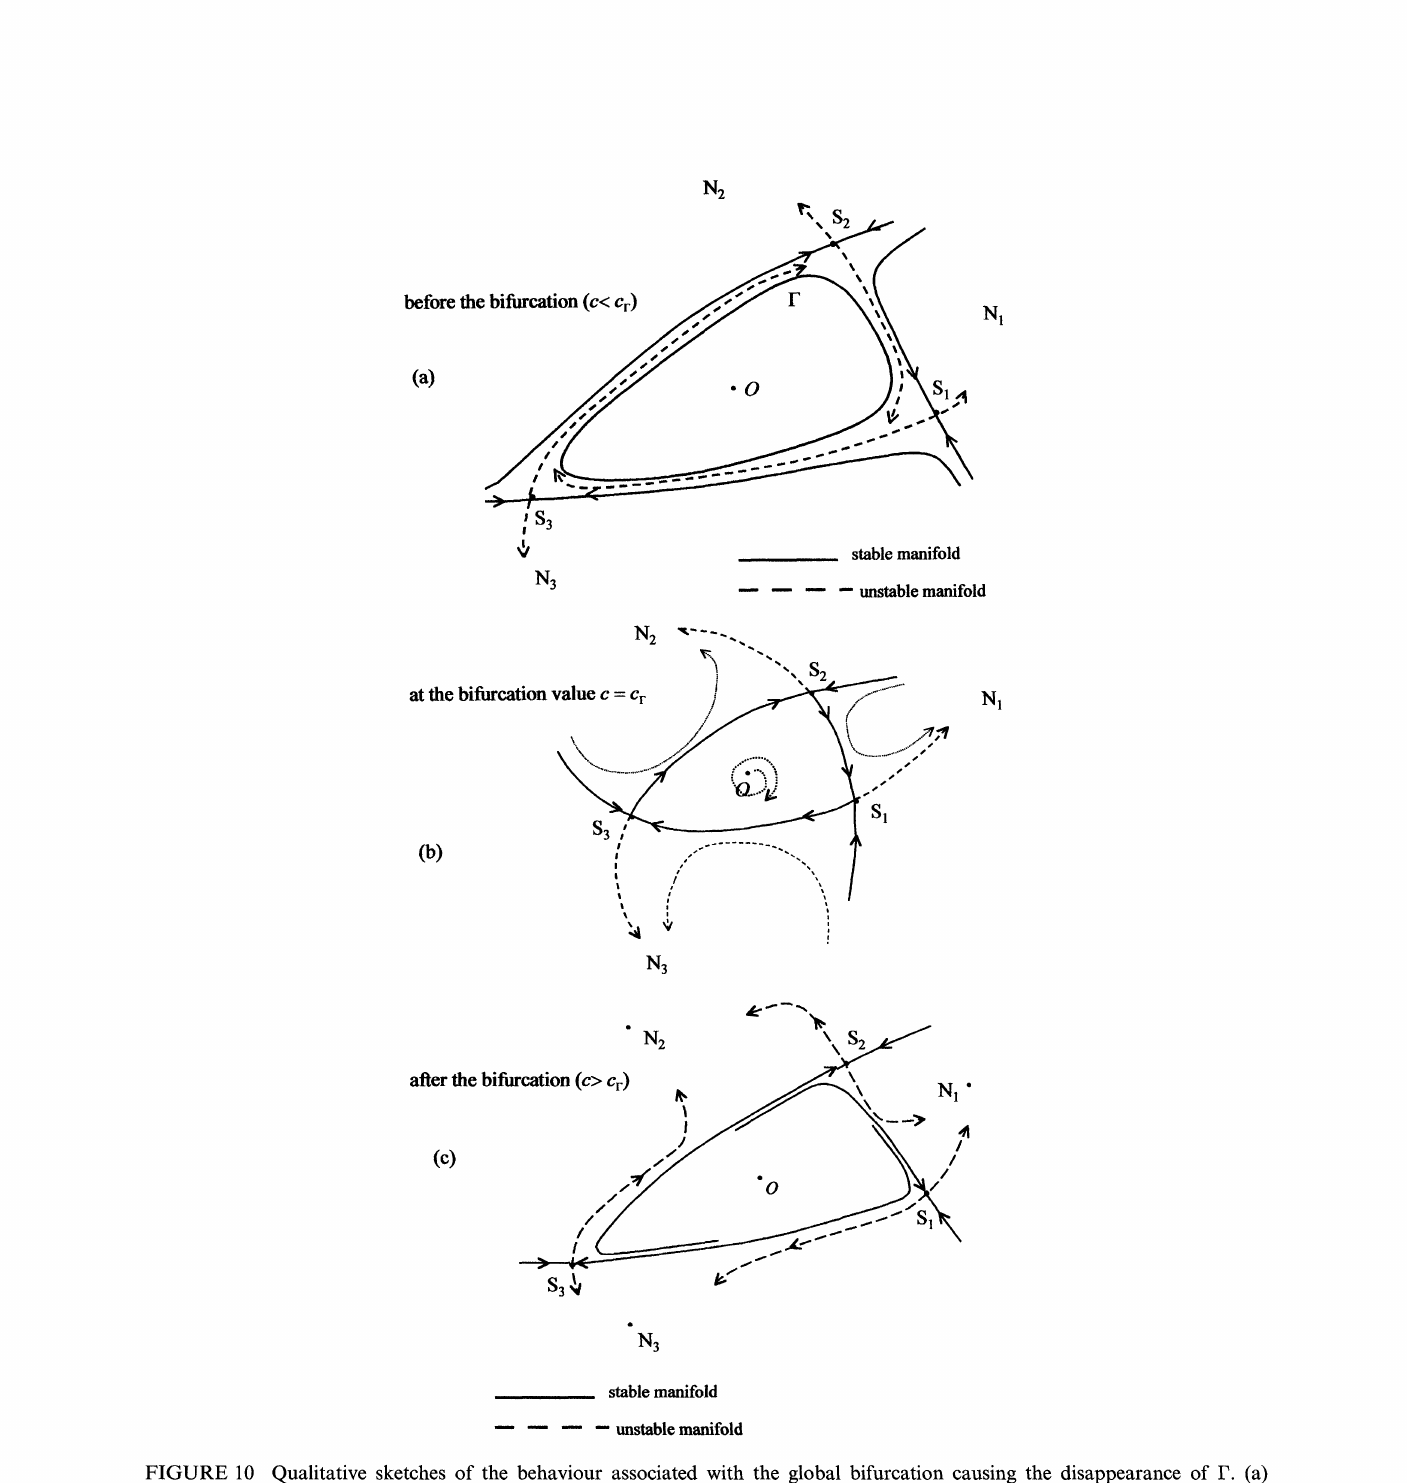
FIGURE 10 Qualitative sketches of the behaviour associated with the global bifurcation causing the disappearance of I represents the behaviour of the stable and unstable manifolds of the saddle points Sg, i= 1, 2, 3, immediately before the bifurcation: the stable sets Ws(Sg), 1,2, 3, bound the basin of I’, while the unstable set WU(Si) of each saddle S has one branch converging to I and the other converging to